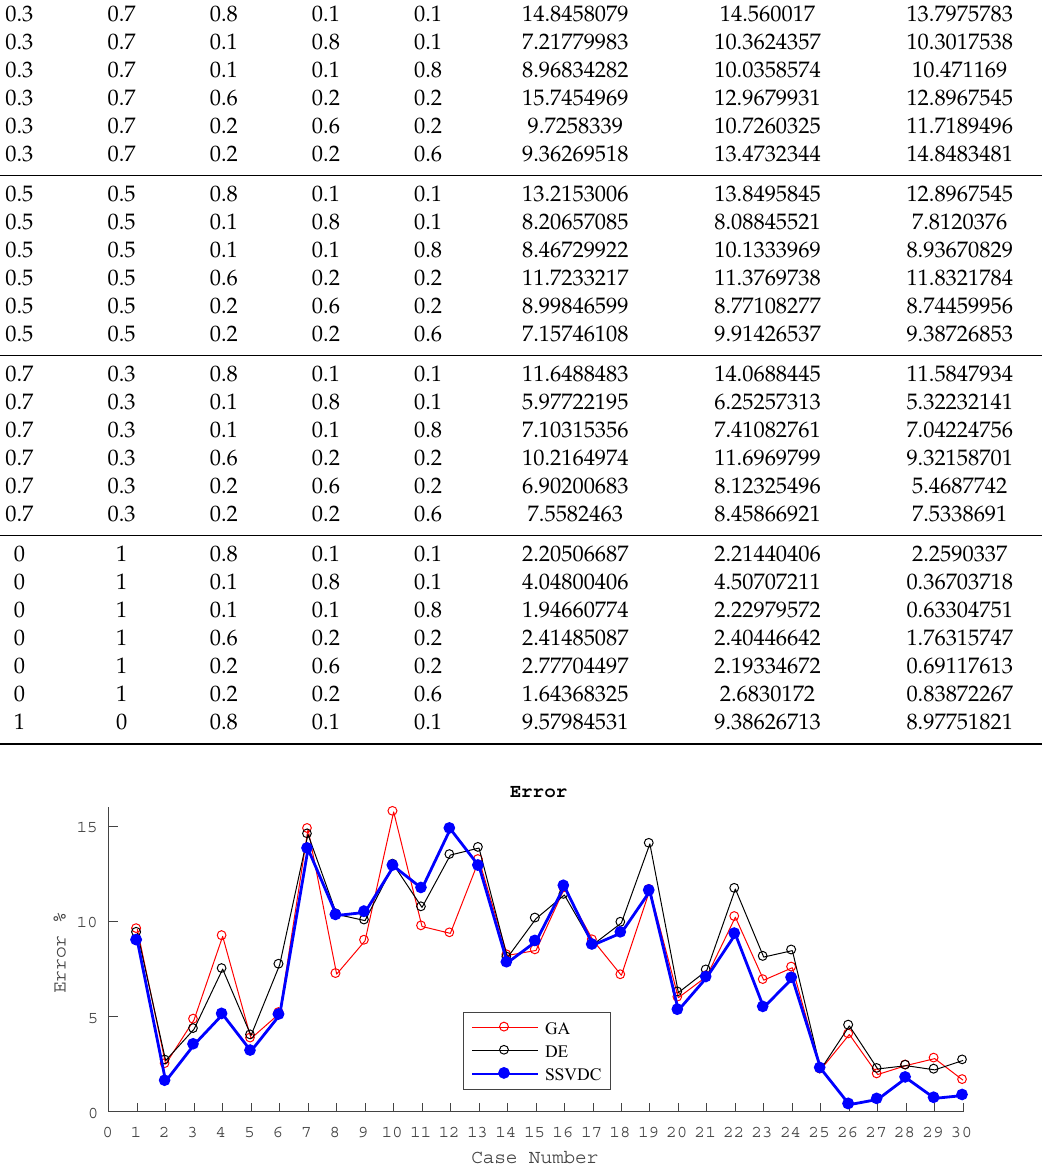
Figure 11. Percentage of error obtained by minimizing the error in 30 cases.